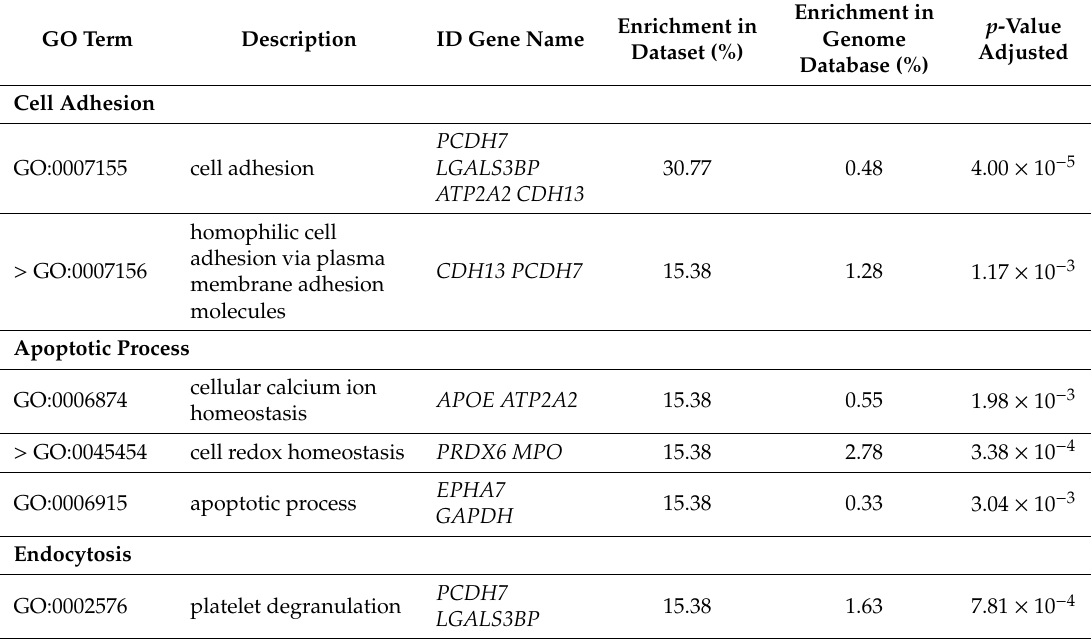
Table 4. Gene Ontology of the 13 predicted secreted proteins in